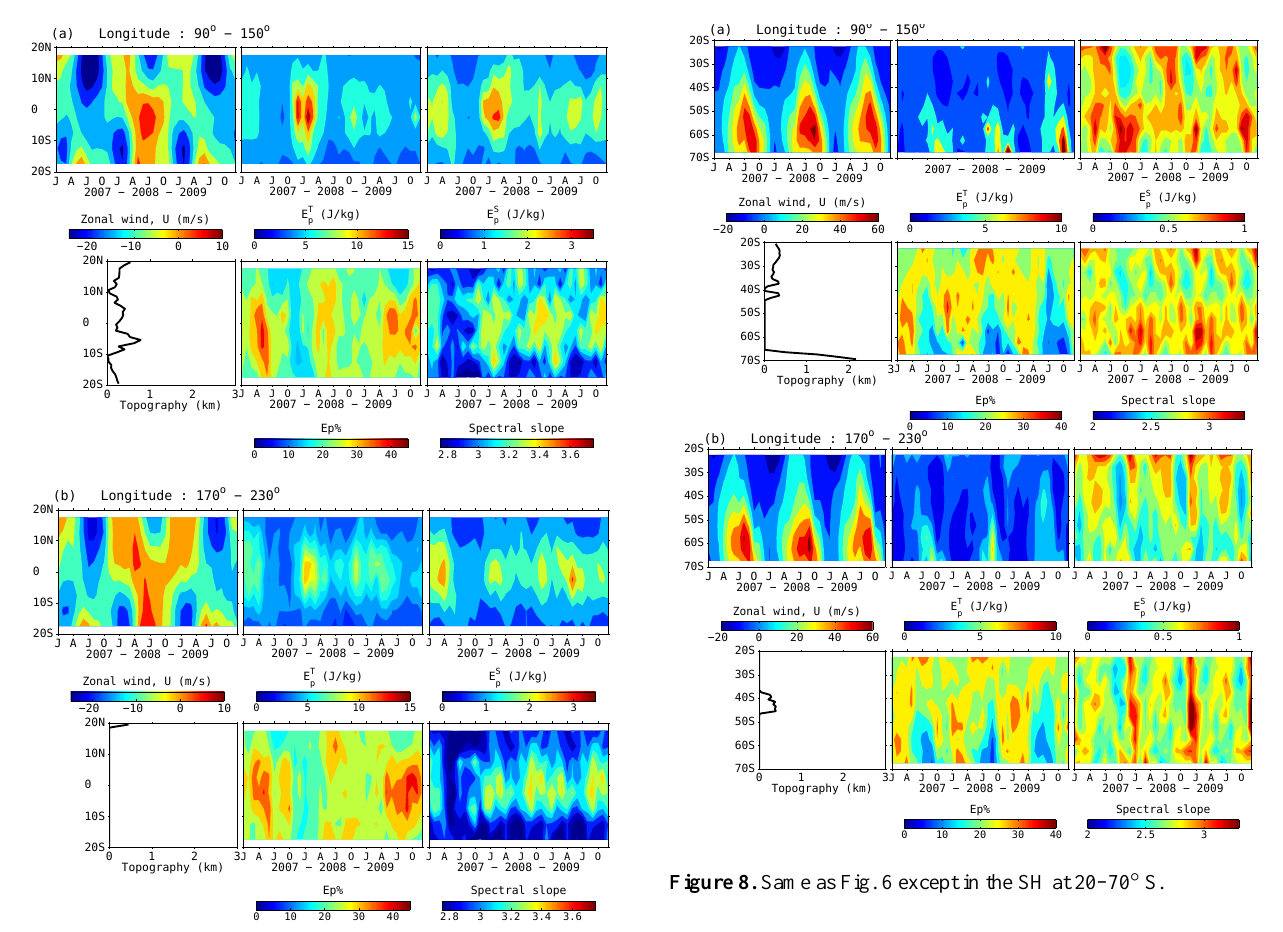
the core of large E S occurred at lower latitudes at 25–40 ◦ N. p The distribution of E S seems to be considerably related to p topography of the Tibetan Plateau, although the wave activ- ity also coincided with U . On the other hand, E T is primarily p affected by U . Absolute p values show an annual cycle ranging between 2.5 and 3.5. Distribution of p is similar to E S , having p